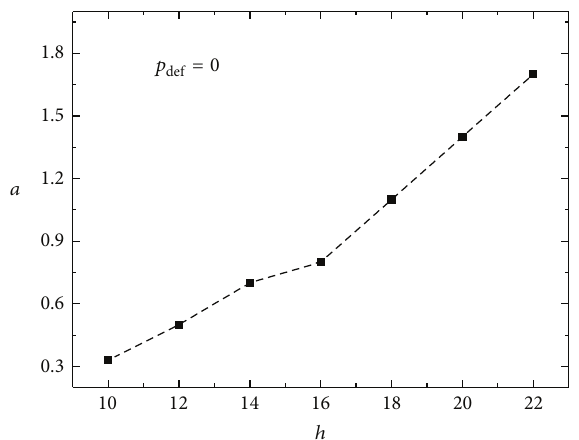
Figure 4: In the figure the critical values of meniscus curvature 𝑎 and the capillary length ℎ are given for which the defect in its equilibrium position is barely attached to the center of the capillary ( 𝑝 def = 0